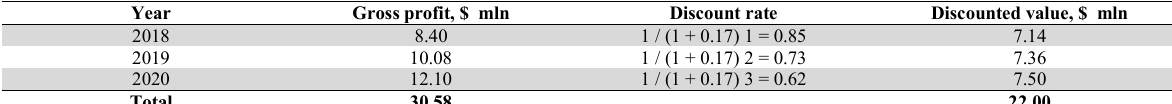
Discounted cost of social networks Year